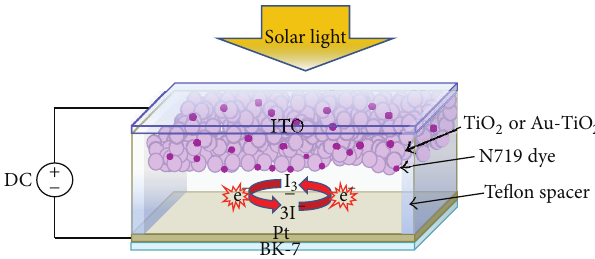
Figure 2: Scheme of fabricated dye-sensitized solar cells (DSSCs).